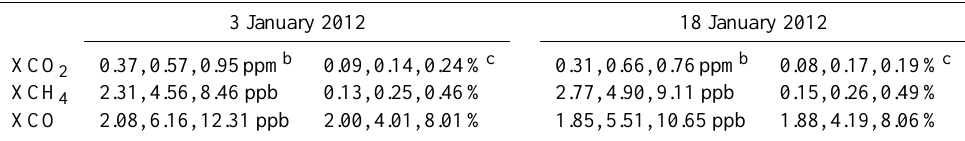
Table 2. Estimated measurement precisions a .